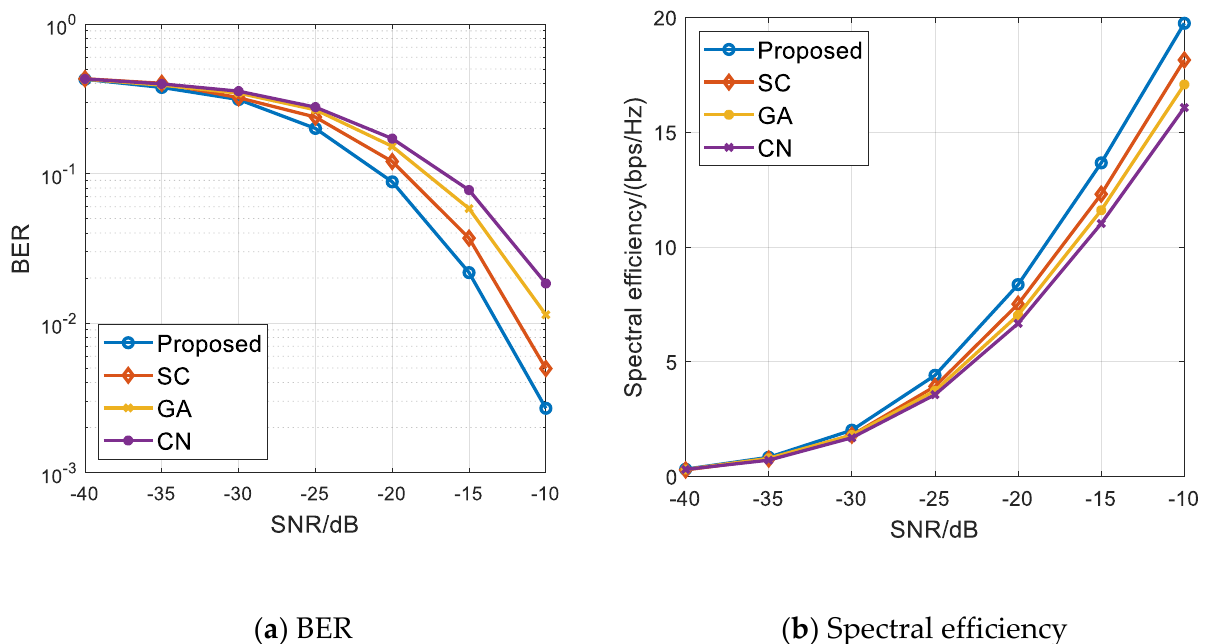
N = . ( a ) BER of all the algorithms; ( b ) Spectral t